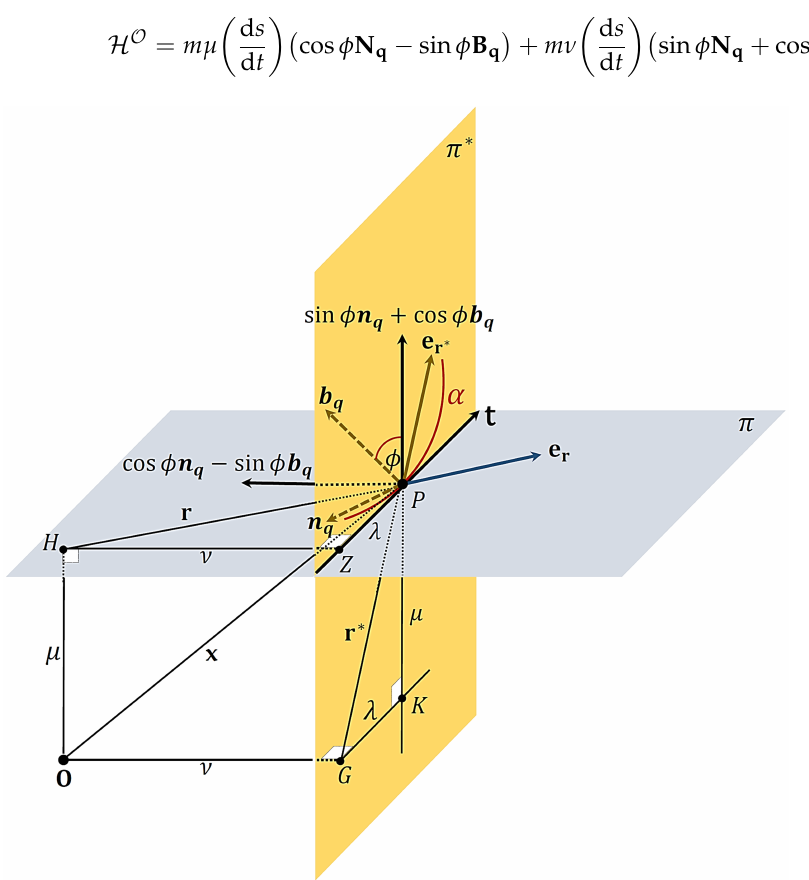
Figure 1. The motion of point particle P along a quasi curve α in E 3